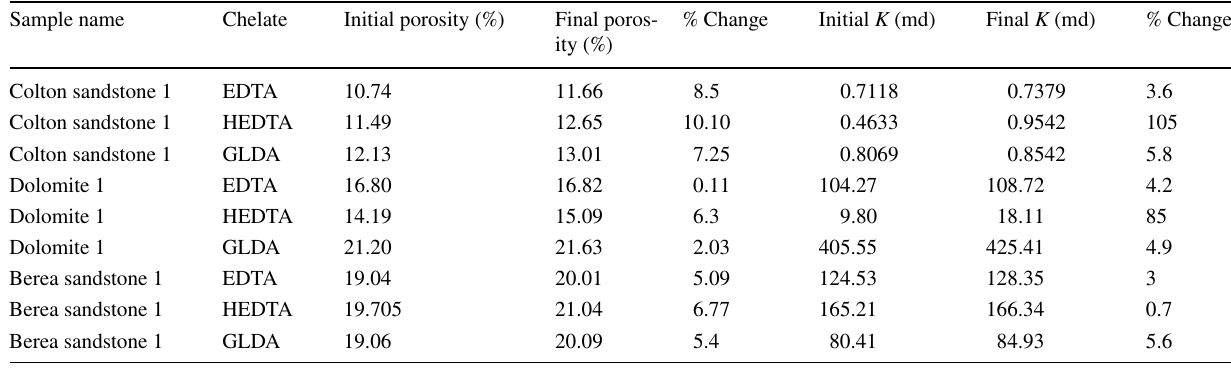
Table 3 Porosity ( ∅ ) and permeability ( K ) results